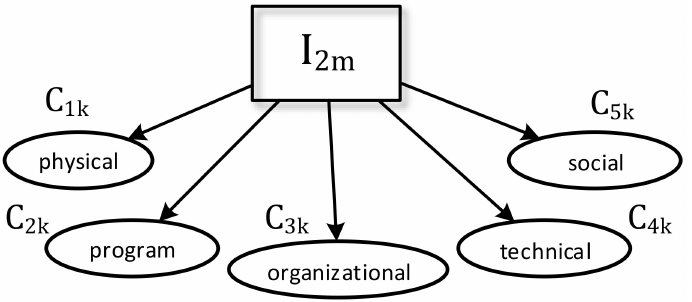
Figure 7. Possible channels of threats of the cyberattack impact on the resources of the SG TDTN. Besides the subgraphs T i and C k , in the formal threat model, there is a bipartite subgraph D g , which, with its vertices protection means of each PIR, and, with the vertices strategy that excludes the threat (Figure 8).